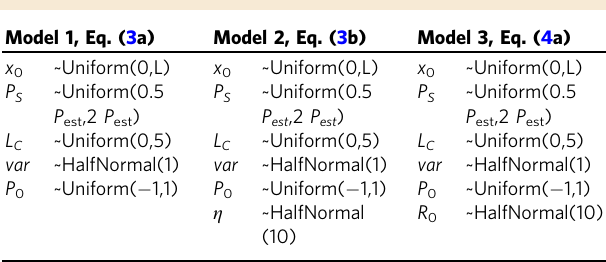
Fig. 1 LGD ferroelectric domain wall models. a – c Free energy vs. order parameter – polarization components P i / P S and ( d – f ) distribution of these P i / P S across the domain wall for Models 1 – 3. Note that we fi xed the coef fi cients a 1 , a 11 , and a 111 , and recalculated the spontaneous polarization P S and parameter η from them for Model 2. For Model 3, component P 1 is not observable by STEM. Table 1 Priors used in